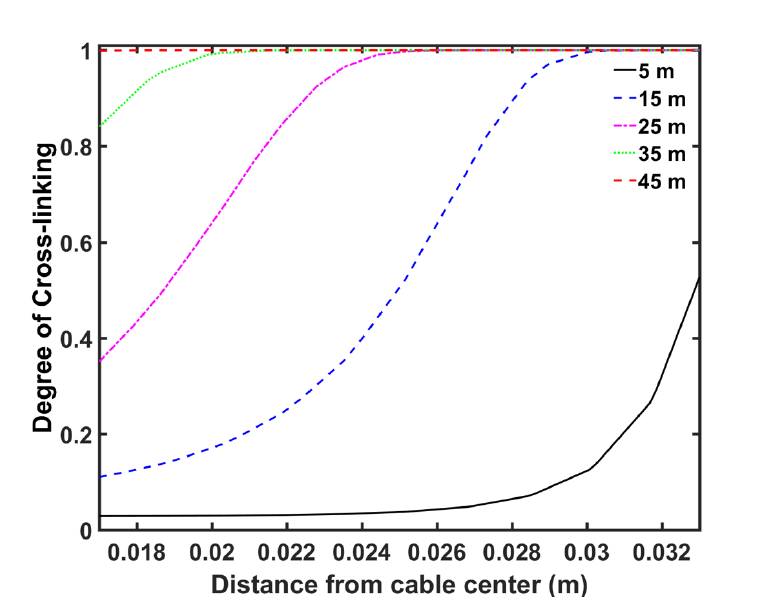
Figure 8. Radial cross-linking profile at different distances from the CV line